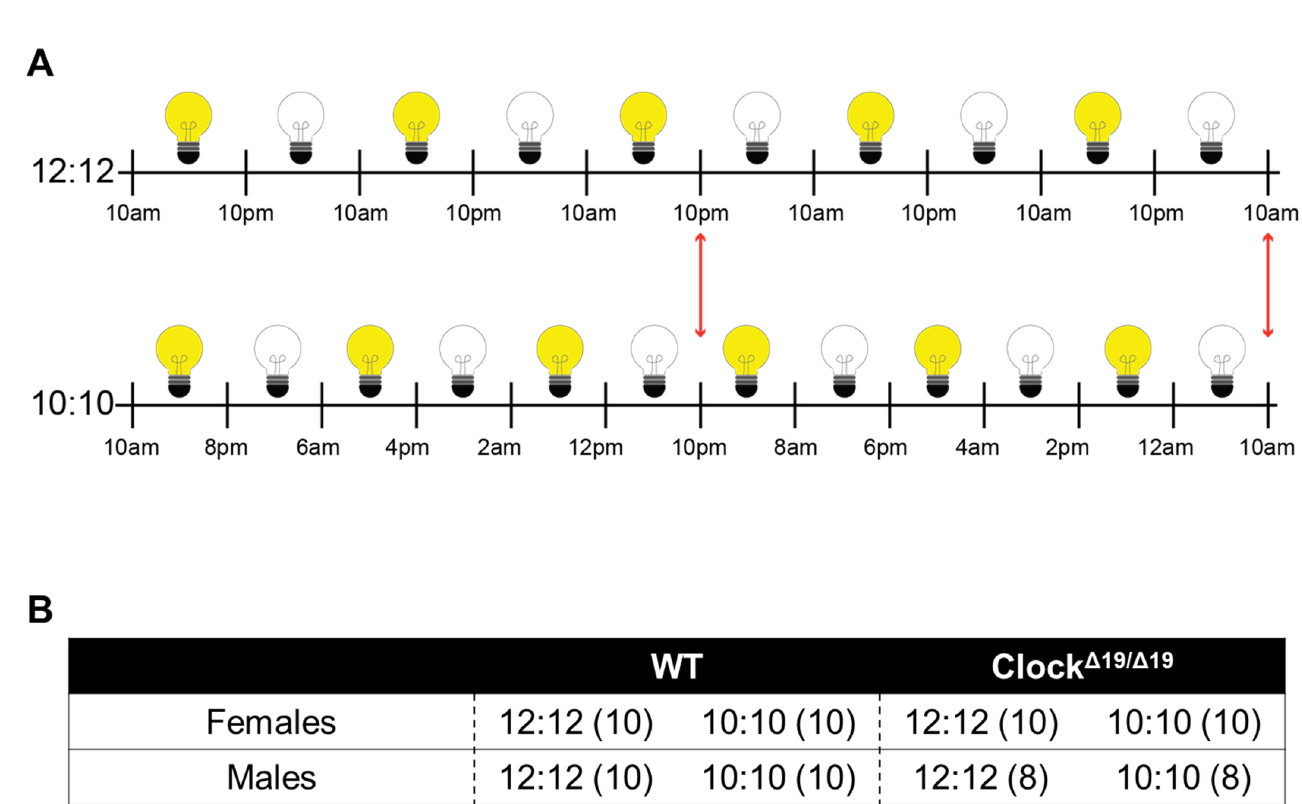
Figure 1. ( A ) Schematic illustrating induced diurnal disruptions through differential light:dark (L:D) cycles in the two study groups. Clear light bulbs signify periods of darkness and yellow light bulbs represent periods of light exposure. After the initial 2.5 days, the two groups are in complete desynchrony (light phase in the 10:10 L:D group, and dark phase in the 12:12 L:D phase; illustrated by the leftmost red double-ended arrow). After the subsequent 2.5 days, the two groups are back in complete synchrony (both begin their light phase; illustrated by the rightmost red double-ended arrow). ( B ) Overview of Study Design; WT (N = 20M, N = 20F) and Clock Δ 19/ Δ 19 mice (N = 16M, N = 20F) were pair-housed with a divider in between. Alcohol drinking, food consumption, and body weight were assessed in male and female WT and Clock Δ 19/ Δ 19 mice under either a normal 12 h:12 h L:D cycle or a 10 h:10 h L:D cycle.